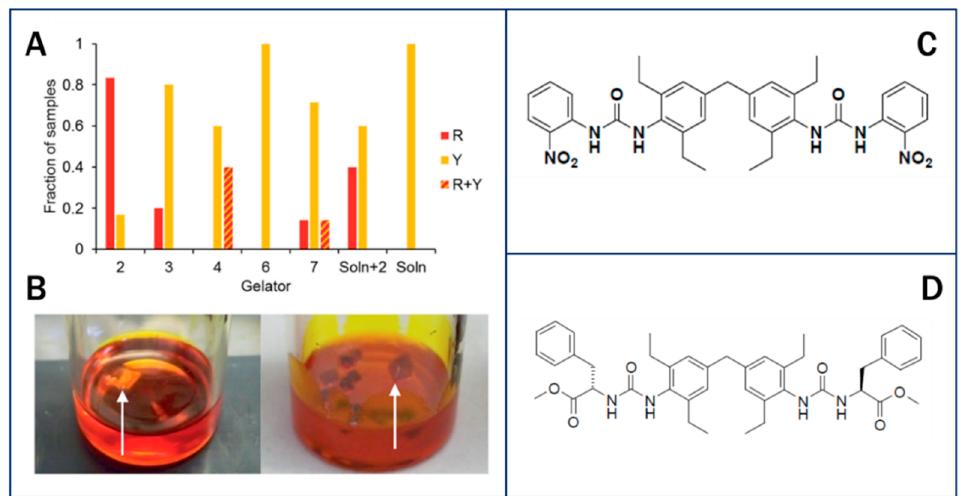
Figure 7. ( A ) Collated data comparing the form of ROY obtained from 100 mg/mL toluene gels of designer gelator 2, non-specific gelators 3, 4, 6 and 7, from toluene solution saturated with 2 and from solution. ( B ) Crystallization of the Y form of ROY from a toluene gel of control compound 7 (left) and the R form from a toluene gel of 2 (right). ( C ) ROY-Specific bis(urea) gelator molecule 2. ( D ) Non-specific L-phenylalanine derivative gelator 7 [118]. Reproduced and modified from [118], The Royal Society of Chemistry, 2017.